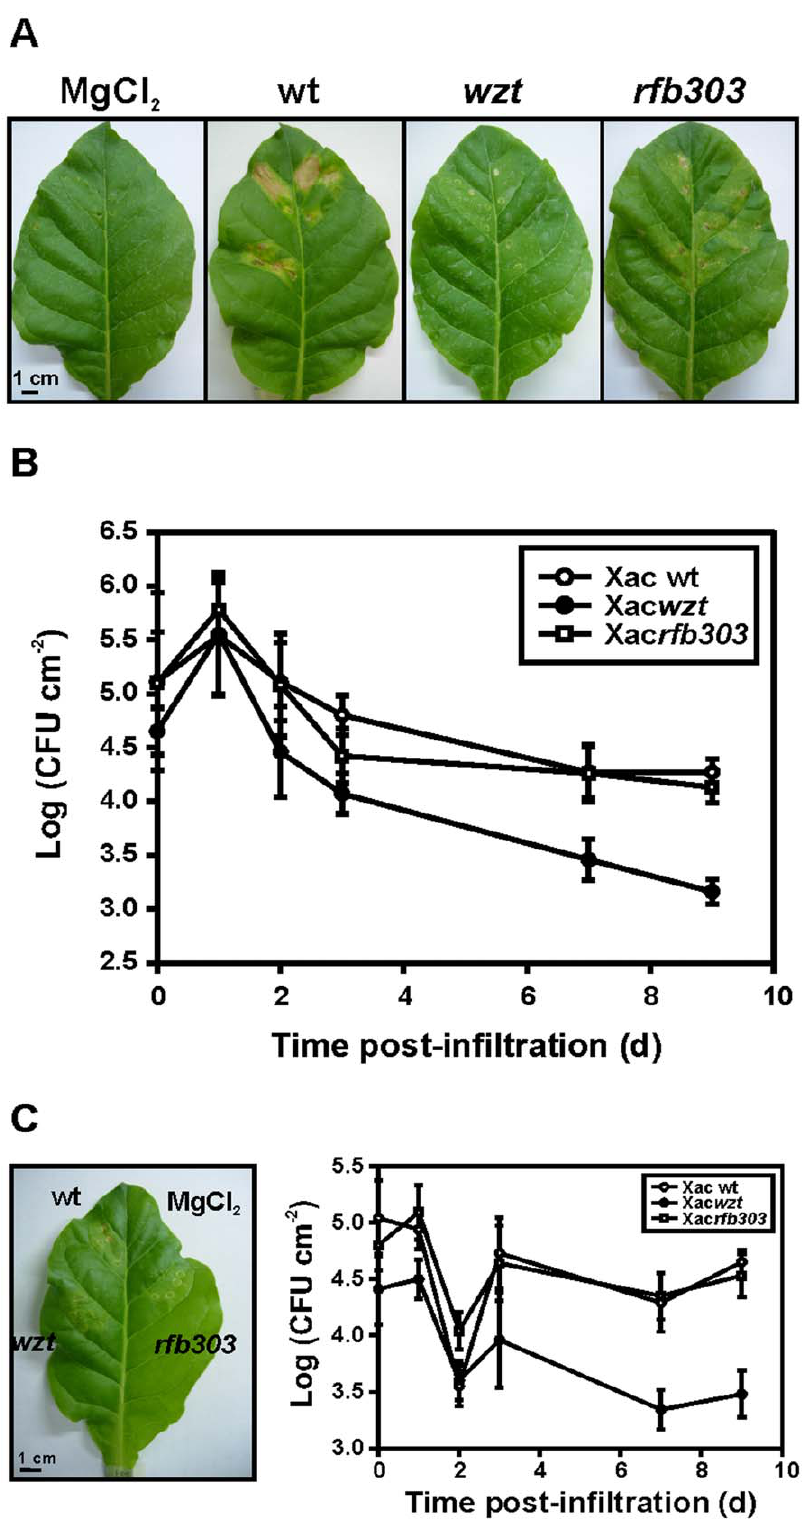
Figure 9. Interaction of Xac strains with non host plants. (A) Phenotype developed on tobacco leaves inoculated with Xac wild-type, Xac wzt and Xac rfb303 at 10 7 CFU ml 2 1 in 10 mM MgCl 2 . Representative leaves are shown 24 hpi. (B) Bacterial growth of Xac wild-type, Xac wzt and Xac rfb303 in tobacco leaves during 9 days. Values represent the mean 6 standard deviation of three independent experiments. (C) Effect of pre-inoculation of tobacco leaves with LPS from Xac wild-type. A tobacco leaf area was inoculated with LPS (100 m g ml 2 1 ) and 20 h later, Xac strains at 10 7 CFU ml –1 were inoculated into the same area. A representative 24 hpi leaf and bacterial growth curves during 9 days are shown. Scale bars, 1 cm.